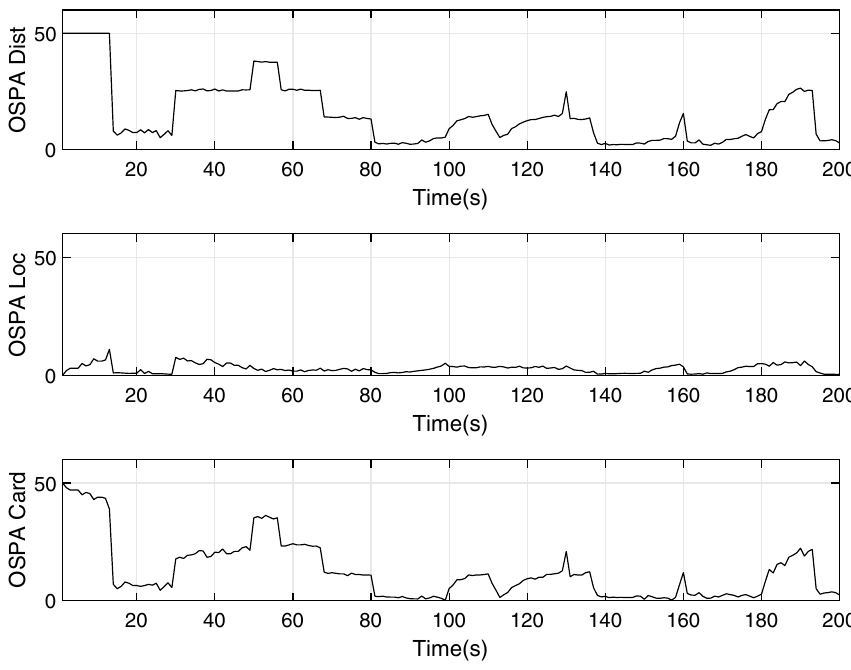
Fig. 6 The OSPA error (50MCs) with considering the blind area